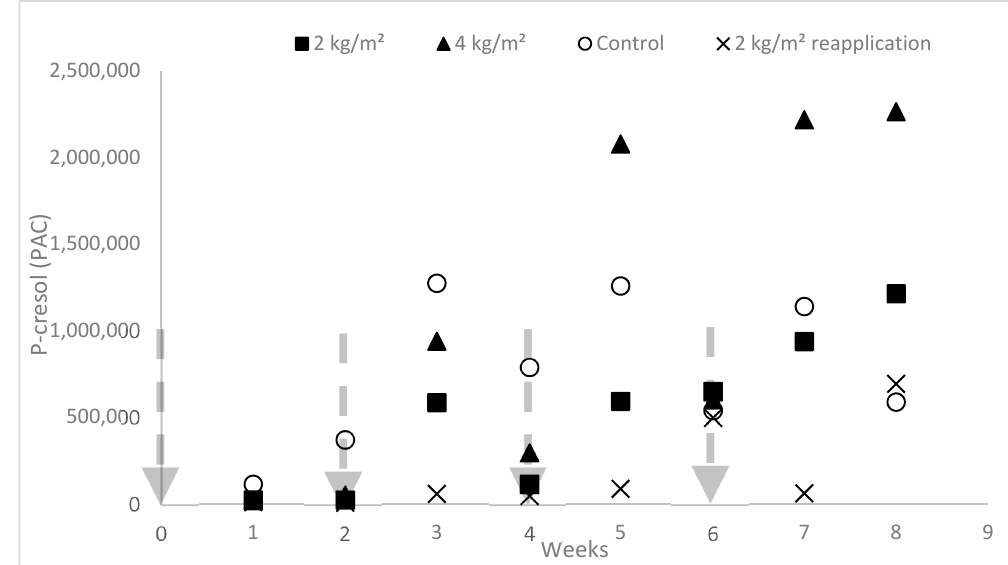
Figure 5. Mitigation of p -cresol (4-methyl phenol) emissions from swine manure treated with biochar—effects of one-time dose (2 and 4 kg/m 2 ) and 2 kg/m 2 bi-weekly reapplication. Vertical arrows represent the application or reapplication of biochar and manure to storage simulators. Each data point represents the mean of ( n = 3) measurements. Detailed statistical analysis is provided in Table S5. A surrogate abundance of indole is represented by (PAC), i.e., peak area counts for indole in the headspace above manure, sampled by SPME and analyzed by GC-MS. PACs are arbitrary units of M.S. detector response.